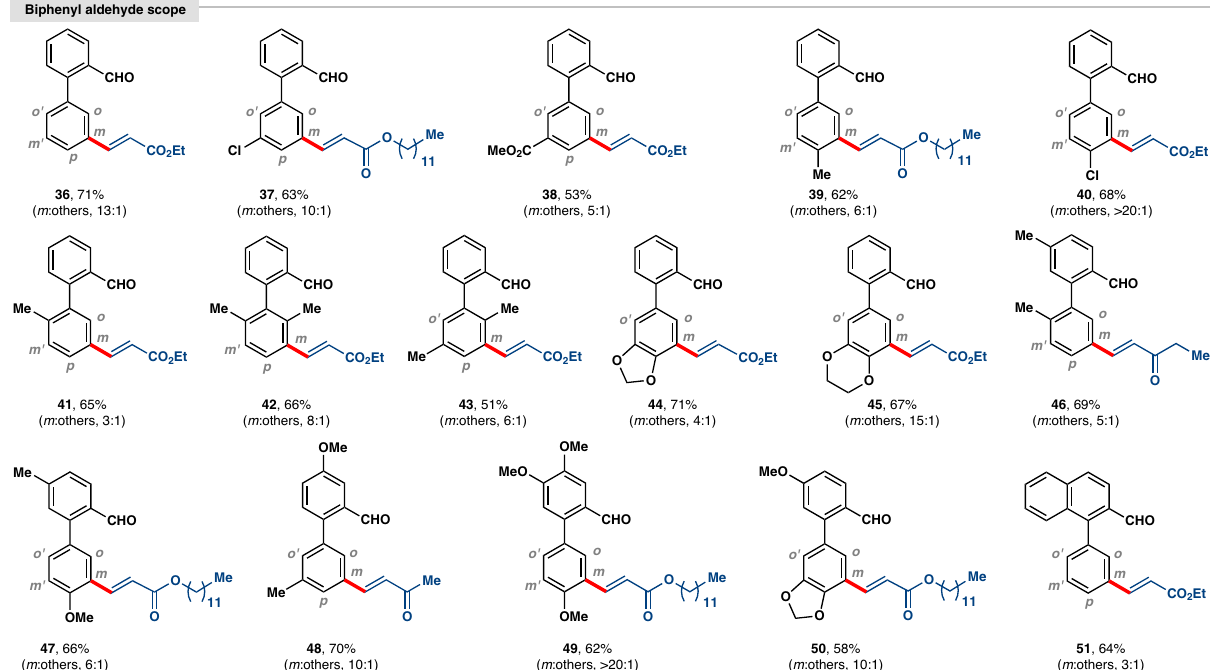
Fig. 4 Biphenyl aldehyde substrates for selective meta -C – H functionalization. The yields are isolated and ratios of meta :others are shown in parenthesis.